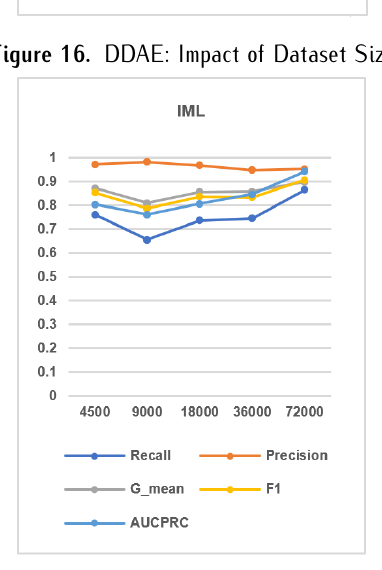
Figure 17. IML: Impact of Dataset Size